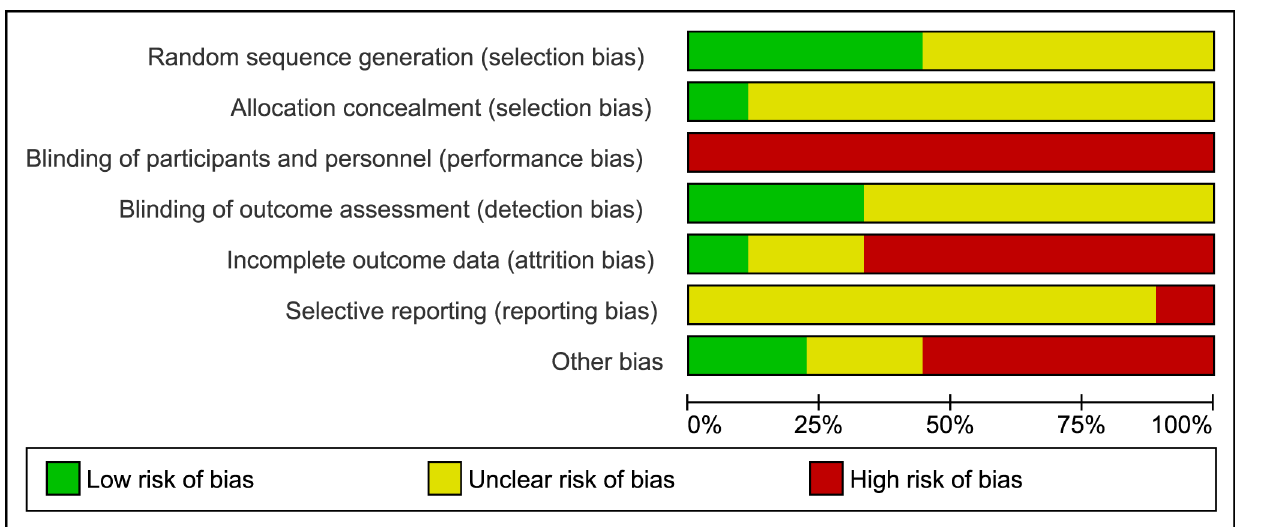
Fig 3. Risk of bias graph: review authors' judgements about each risk of bias item presented as percentages across all included studies.